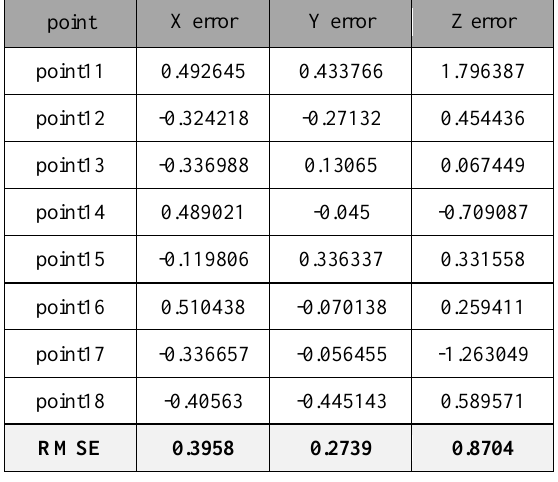
Table 3 The RMSE -only GCP ( Unit: m)